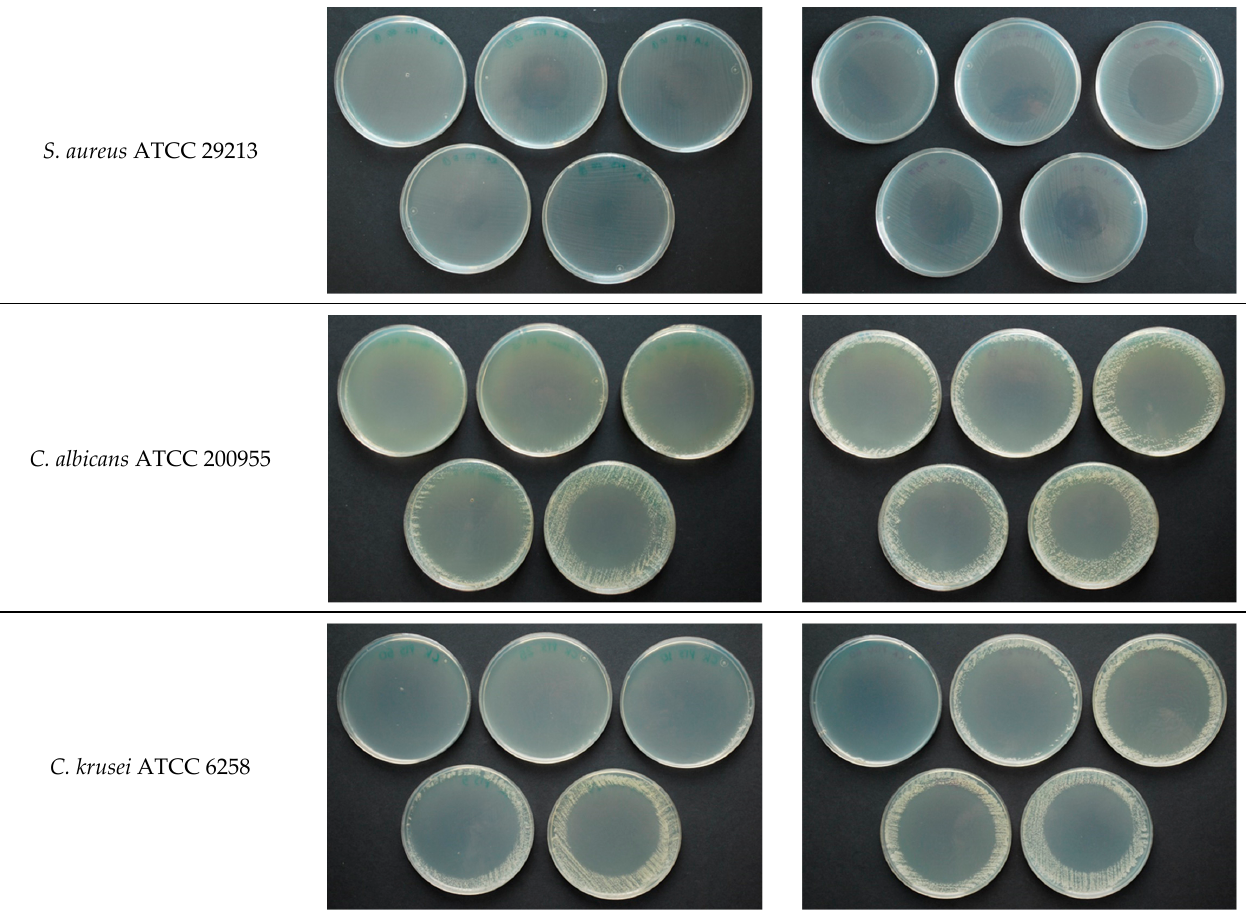
Figure 1. Antimicrobial activity of PTS and PTSO via the gas phase. Photograph showing halos of inhibition at doses of 50 mg/mL, 25 mg/mL, 10 mg/mL, 5 mg/mL, and 2.5 mg/mL (from left to right and from top to bottom). Although assays were carried out at 0.5, 1, and 2 McFarland turbidity, only the results at 0.5 McFarland are shown. As it is shown in Figure 2 and Table 2, diameters from the inhibition of growth zones were directly related to the concentration of PTS or PTSO used, and inversely related to the microbial inoculum used: the higher the concentration of PTS or PTSO were and the lower the inoculum of microorganisms were, the larger the diameter of the halo was ( p < 0.001). Greater halos and, consequently an increased susceptibility to these compounds were observed in the case of yeasts ( C. albicans ATCC 200955 and C. krusei ATCC 6258).